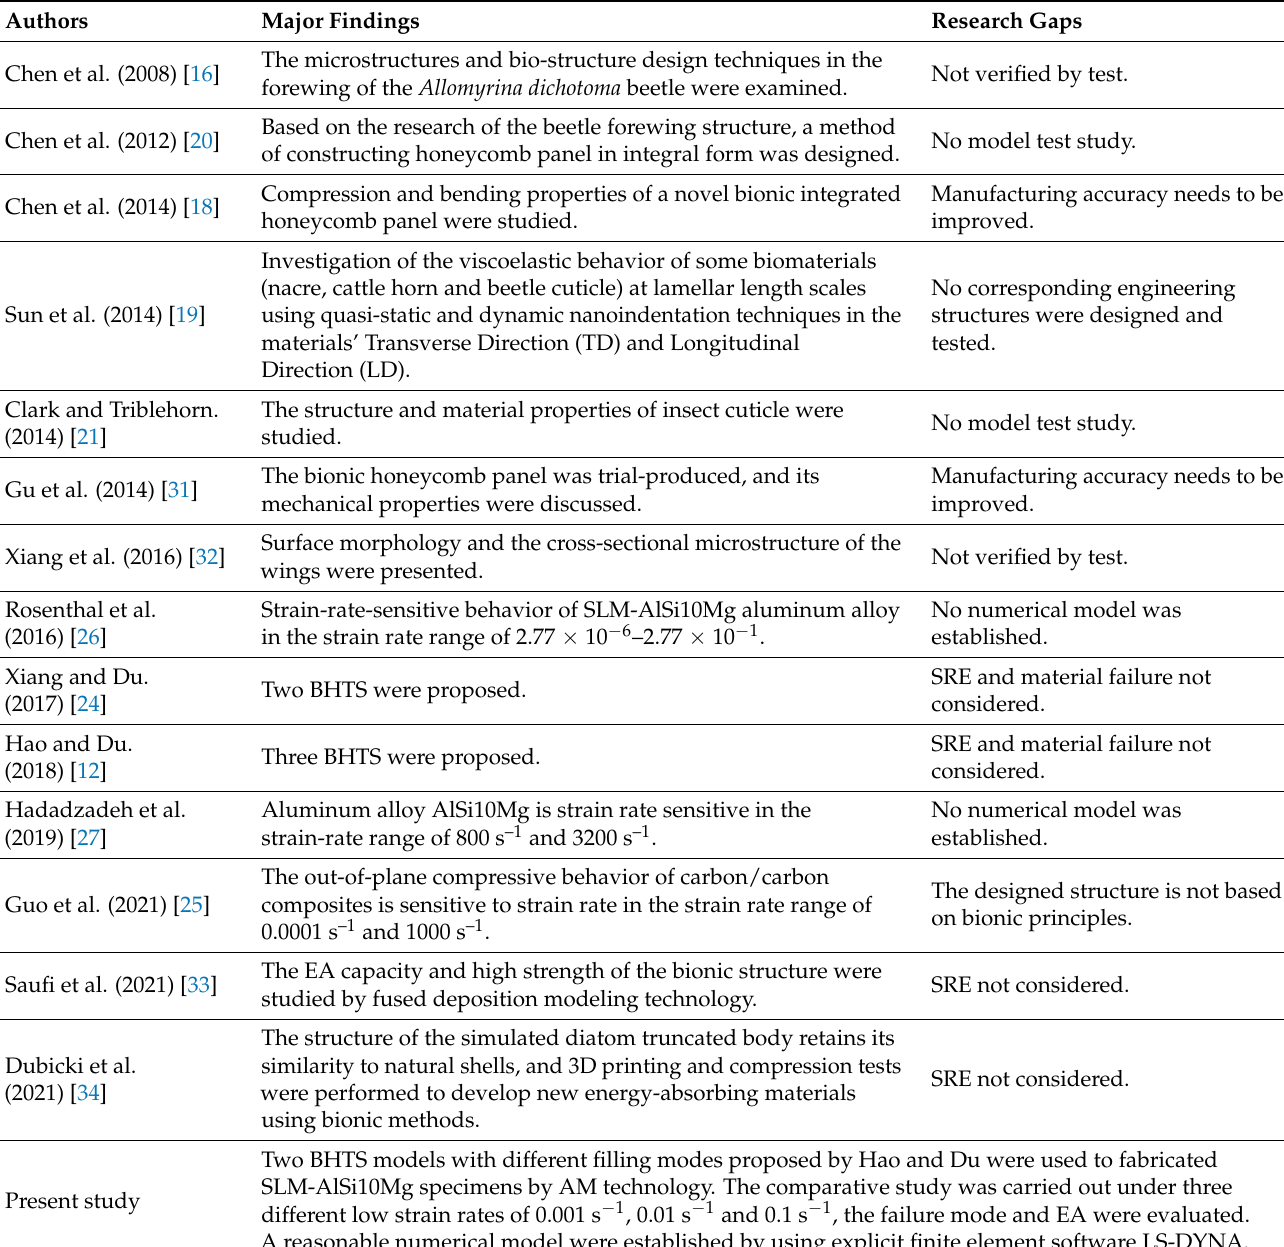
Table 1. Comparison of present study with some major